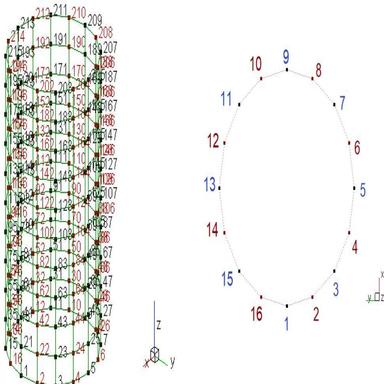
Geometric coordinate system of the pipe.